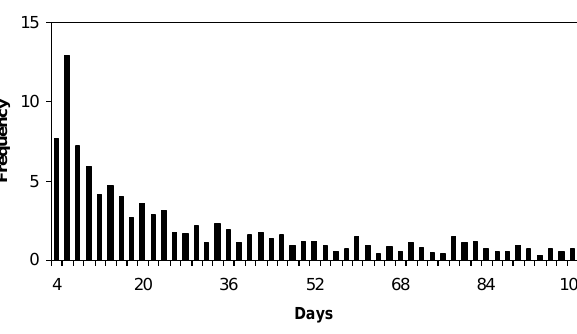
Fig. 11. Probability maps for the OES-WLL, with similar features Figure 11. Probability maps for the OES-WLL with similar features to the 2002-03 eruption. 678 to the 2002–2003 eruption. Thresholds considered are: (a) 200 and (b) 100kgm − 2 . Thresholds considered are: a) 200 and b) 100 kg m -2 . 679